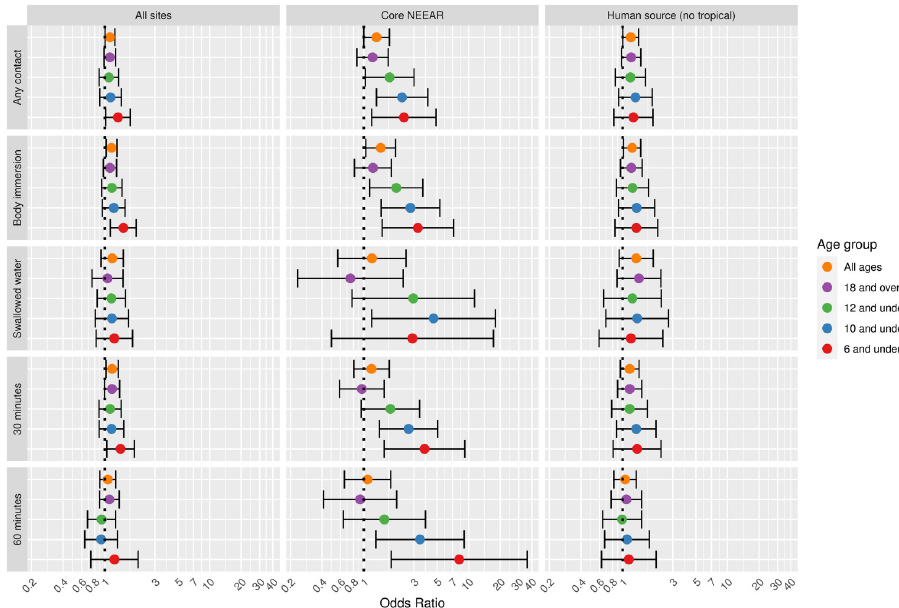
Fig 5. Odds ratios for severe gastrointestinal illness among swimmers associated with a 1-log10 increase in Enterococcus qPCR CE.